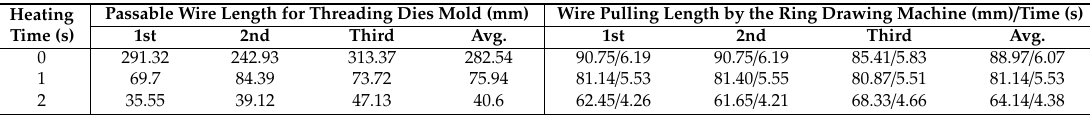
Table 8. Results based on wire pulling speed:k8(14.66 mm / s).